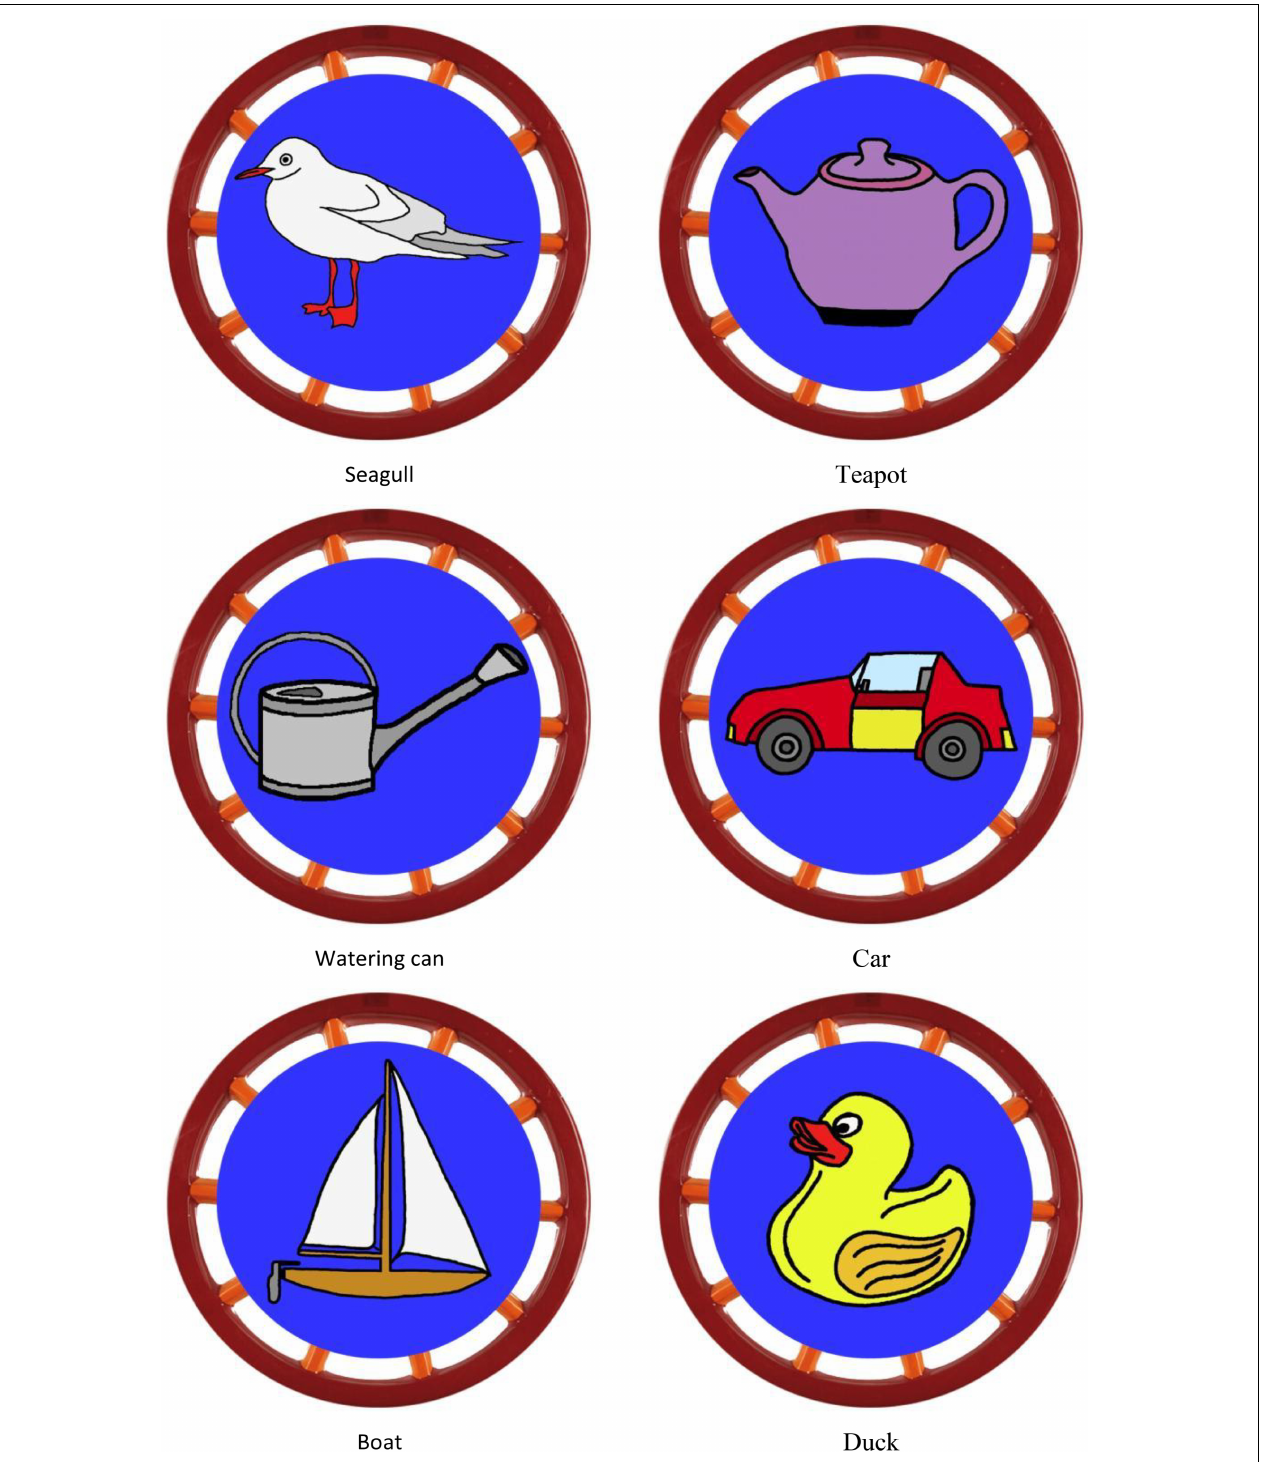
FIGURE A1 | Display of all stimuli fitted with the